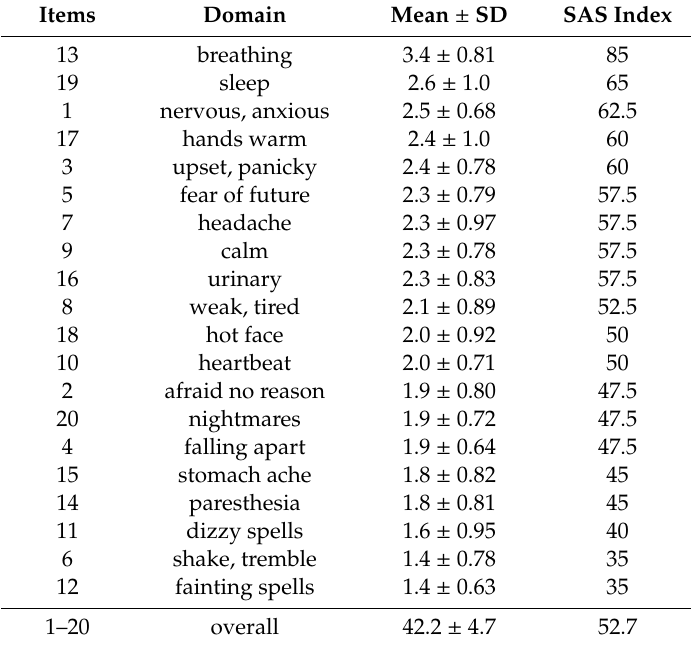
Table 1. Self-Rating Anxiety Scale (SAS): mean, standard deviations, and SAS index listed in descending